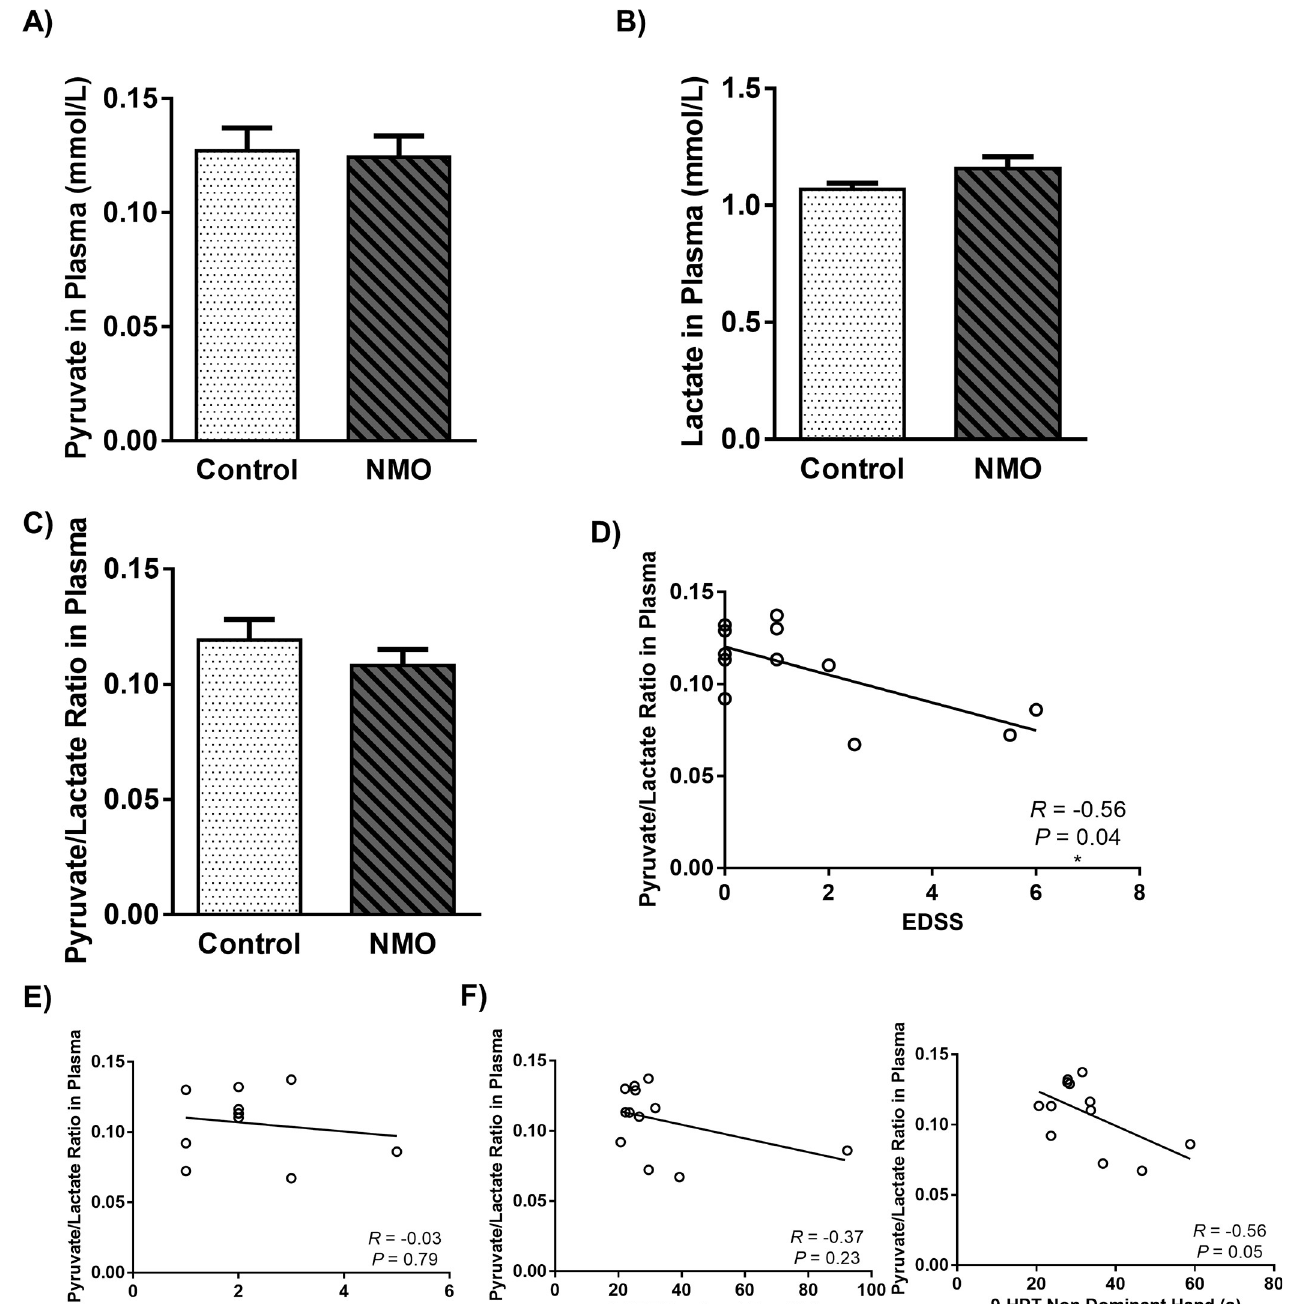
Fig 5. Level of pyruvate (a) , lactate (b) and pyruvate to lactate ratio (c) in Plasma of Neuromyelitis Optica (NMO) patients compared to control group. Each point shows the mean ± SEM. The correlation of Pyruvate to lactate ratio in plasma with the expanded disease status scale (EDSS) (d) , number of attacks (e) and 9-Hole Peg Test (9-HPT) in dominant hand and non dominant hand (f) of NMO